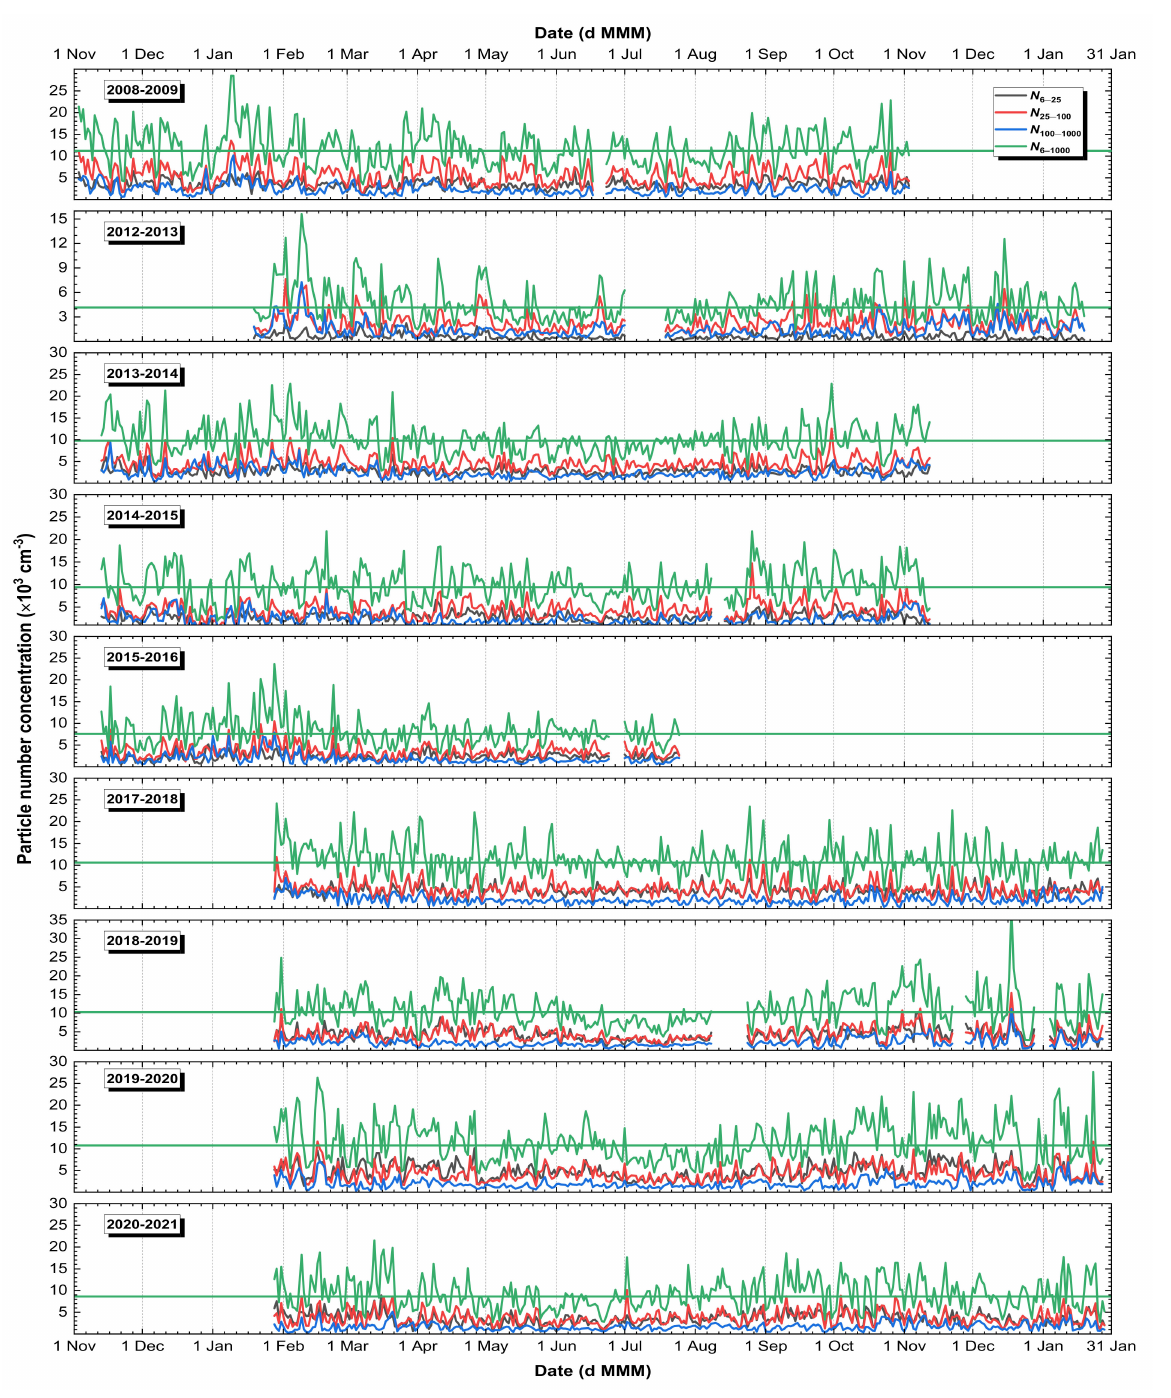
Figure 1. Time series of daily median particle number concentrations N 6–25 , N 25–100 , N 100–1000 , and N 6–1000 for the nine measurement years. The year 2012–2013 (Y2) was realized in the near-city background, while in the other years, the measurements were accomplished in the city center. The solid line represents the annual median N 6–1000